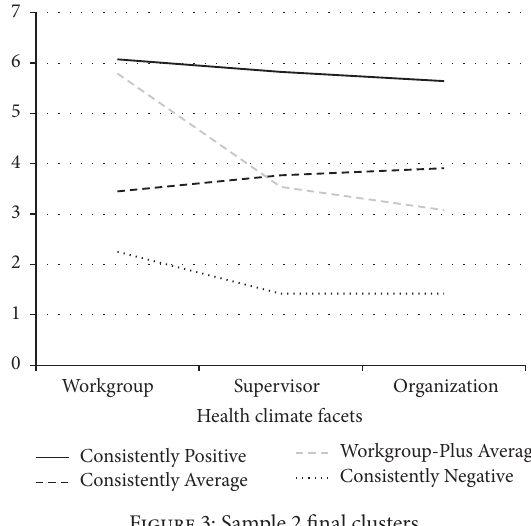
Figure 3: Sample 2 final clusters.